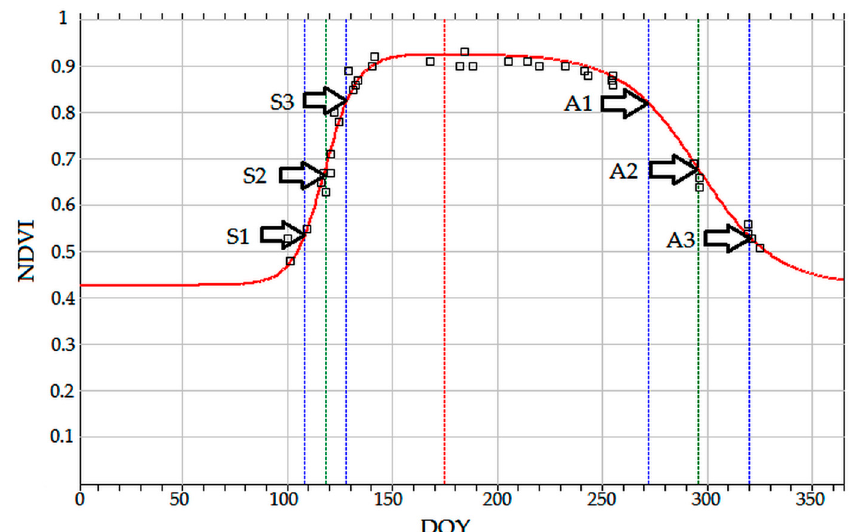
Figure 2. Graphical illustration of NDVI MOD seasonal profile fitted by a sigmoid logistic function with the inflection points of the first derivative (phenological metrics S2 and A2), and the local minima and maxima of the second derivative (phenological metrics S1, S3 and A1, A3 for the spring and autumn period, respectively). NDVI, normalized difference vegetation index. DOY, day of year.